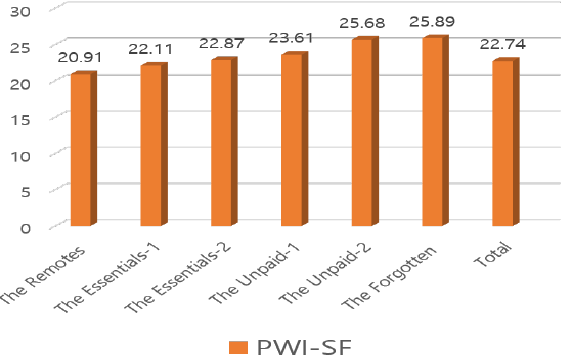
Figure 3. (PWI-SF, Psychosocial Well-being Index short form) Participants’ psychological health by our Korean-adapted version of the new classes of occupation owing the COVID-19 pandemic.